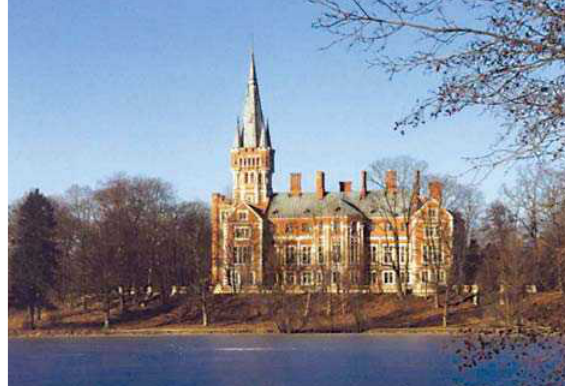
Fig 1. Project of public Sefton Park in Liverpool, UK (arch E. Andre,